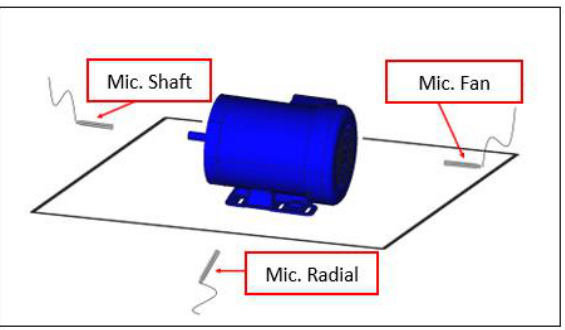
Figure 3. Schematic of motor setup and microphone positions.